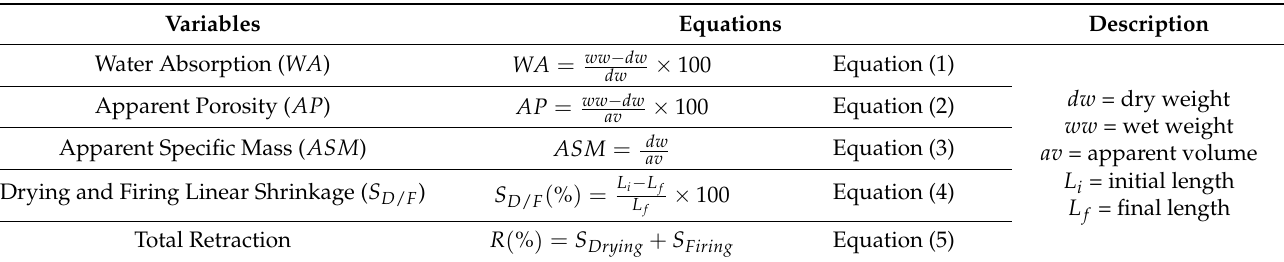
Table 1. Equations of technological tests.